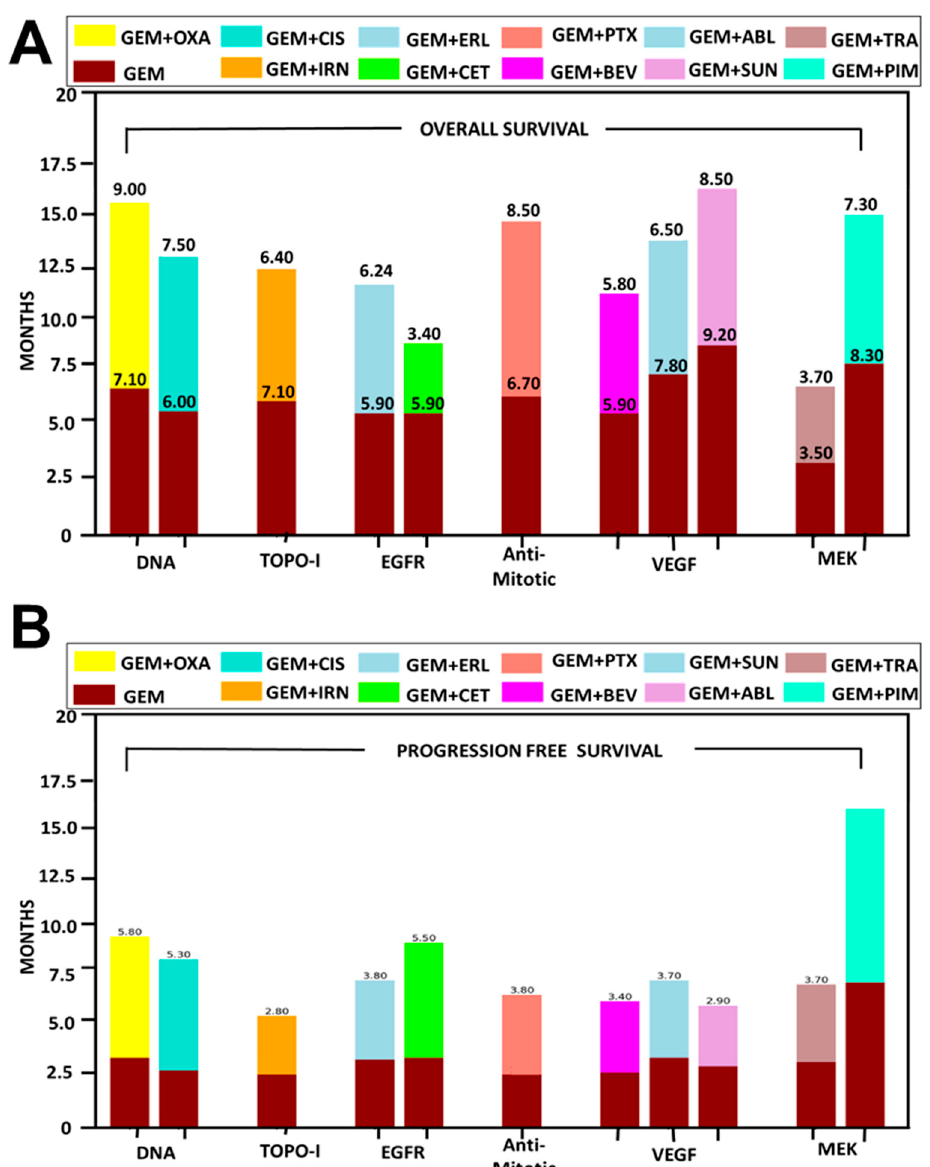
Figure 2. A detailed analysis of GEM co-administration outcomes with other drug candidate in terms of ( A ) overall survival and ( B ) progression-free survival of patients through various clinical trials.